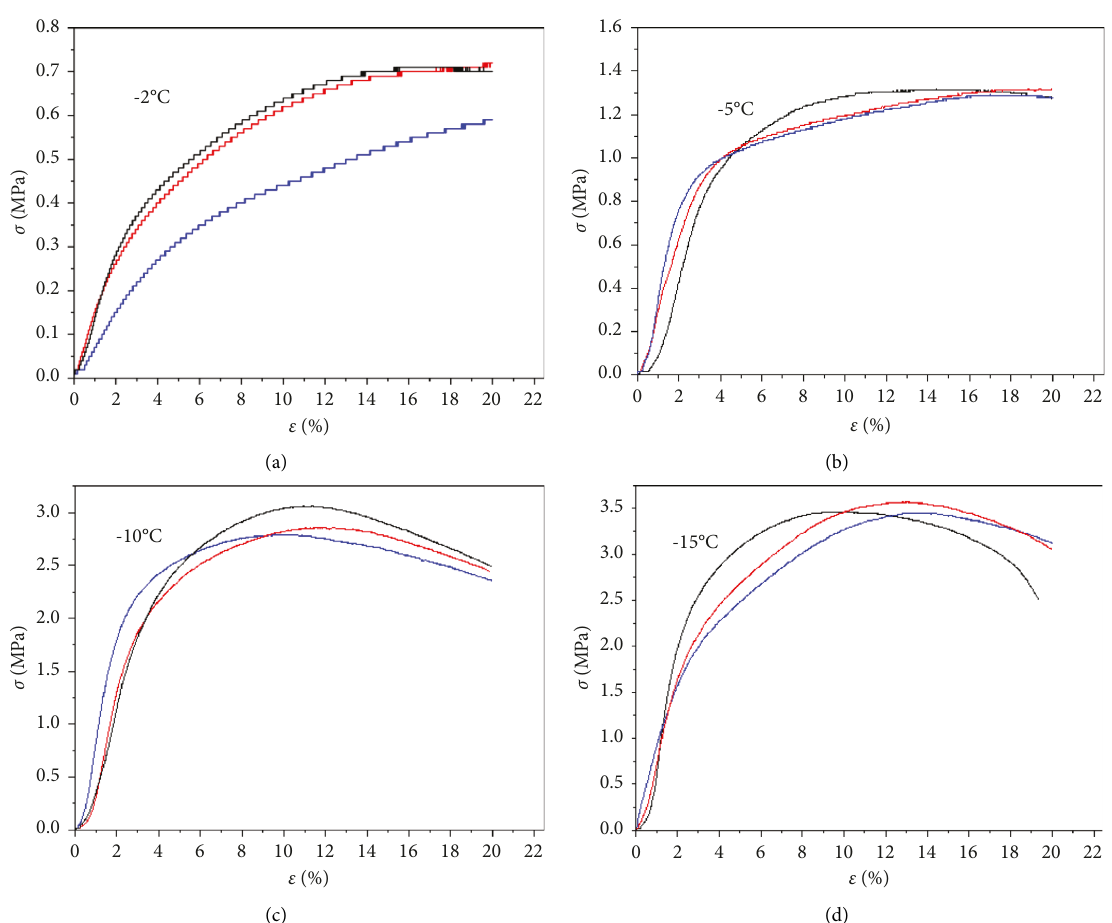
Figure 3: Stress strain curve of frozen red clay at different temperatures.